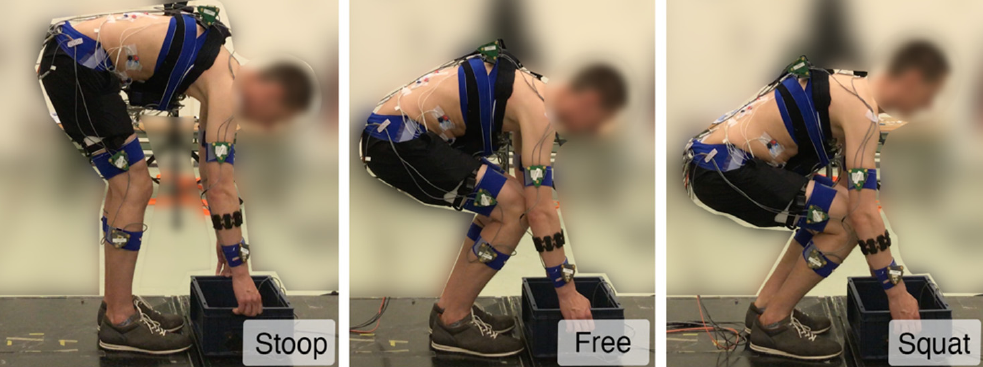
Figure 3. Participants lifted the box with different techniques: ( Stoop ), keeping knees extended and reaching the box with trunk flexion; ( Free ), a self-selected combination of knee and trunk flexion; ( Squat ), keeping trunk extended and reaching the box with knee flexion.